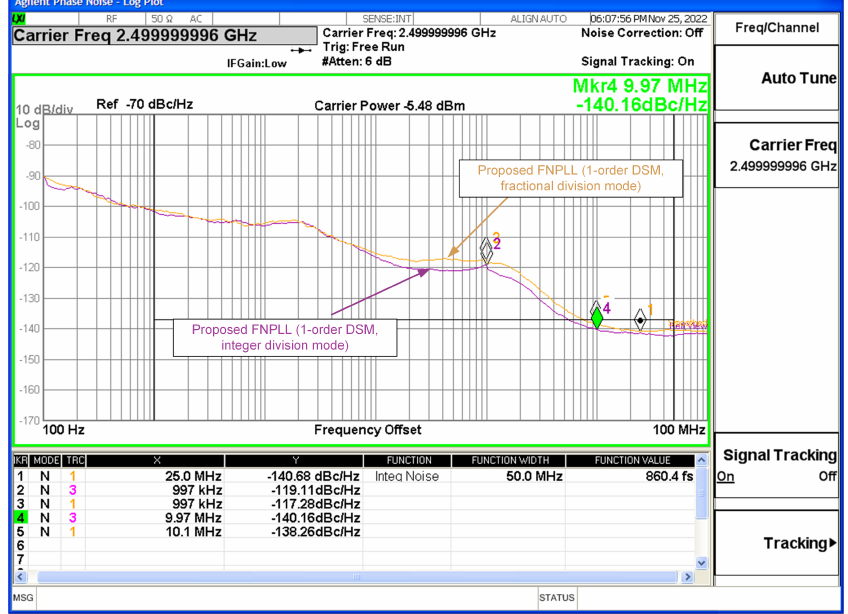
Figure 14. Measured results of phase